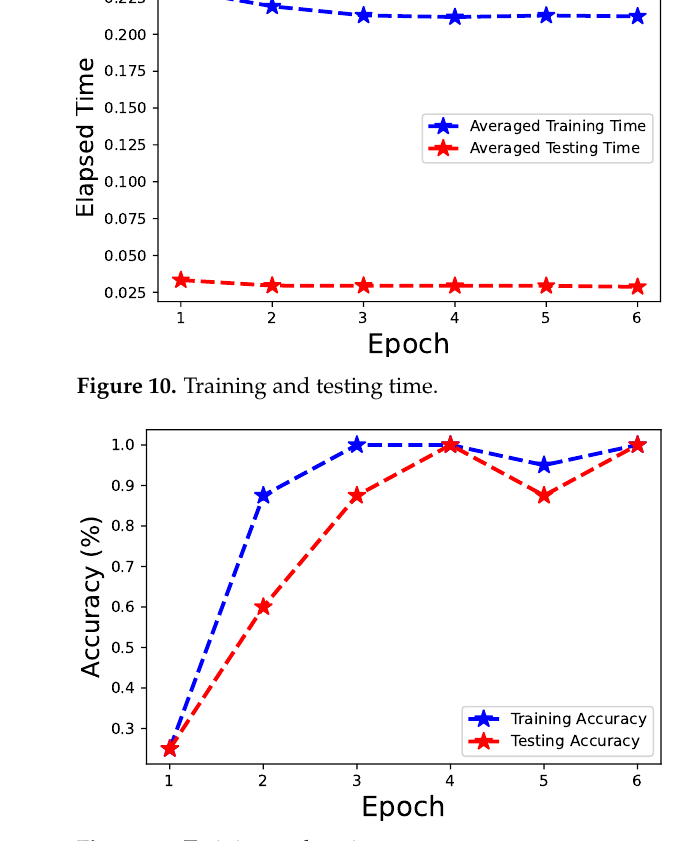
Figure 11. Training and testing